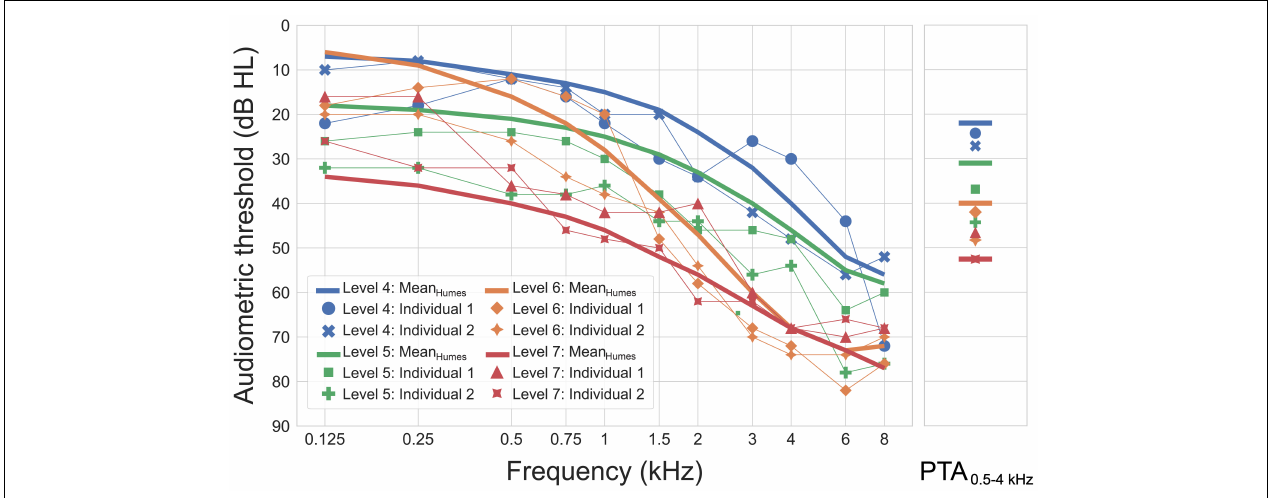
FIGURE 2 | Audiograms used as an input for the simulation of hearing loss. Corresponding pure-tone averages (PTAs) for frequencies between 0.5 and 4 kHz are shown in the right panel. Figure reproduced from Gonçalves Braz et al.